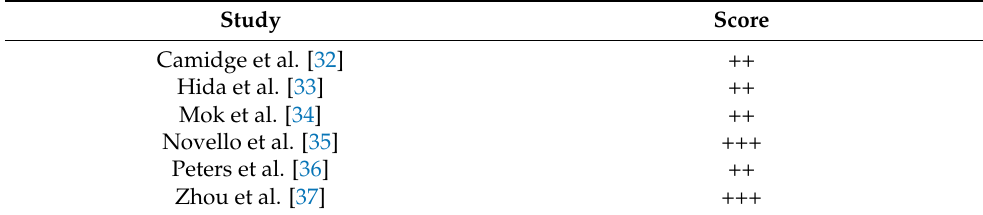
Table 3. Quality